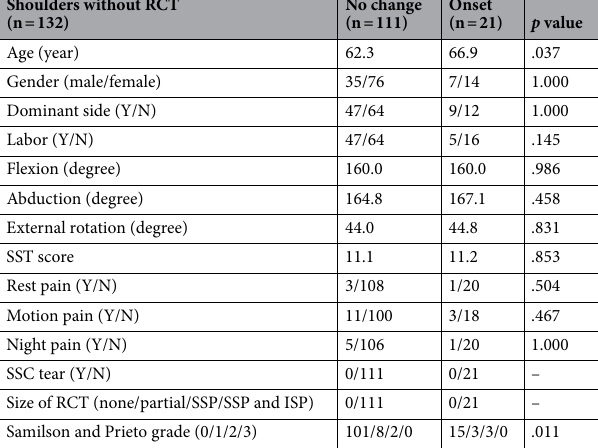
Shoulders without RCT (n =